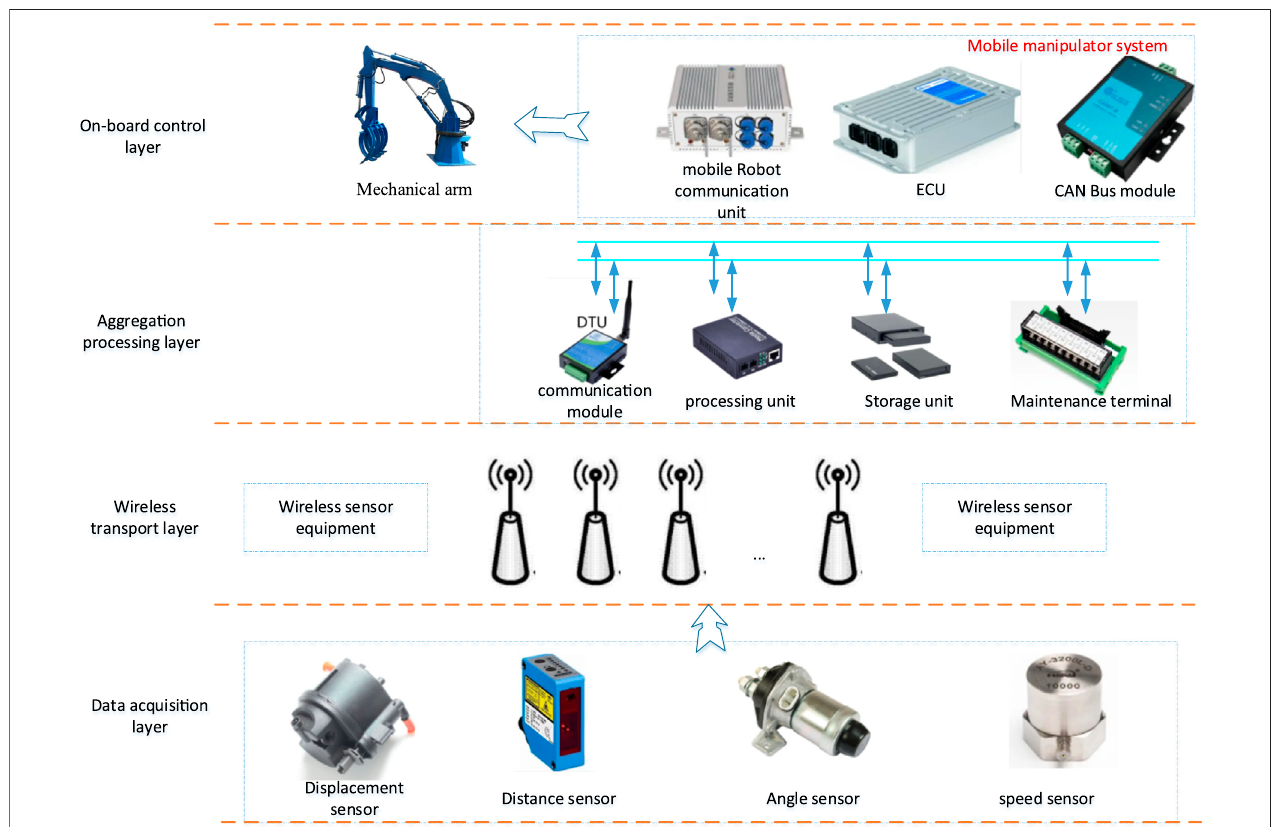
FIGURE 1 | The structure design of bio-inspired mobile manipulator based on synchronous sensing.